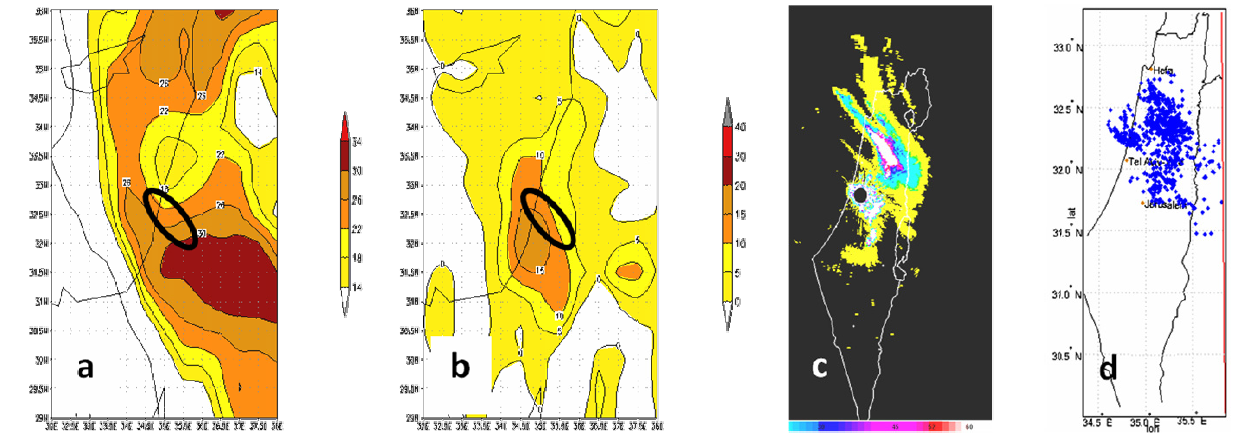
Fig. 4. As in Fig. 3, but for the second phase, 2 April 2006, 06:00UTC. The radar derived rainfall is integrated over the period 2 April 2006, 06:00–12:00UTC and the lightning distribution – 2 April, 00:00UTC–3 April, 00:00UTC. The bold ellipses in (a) and (b) denote the maximum